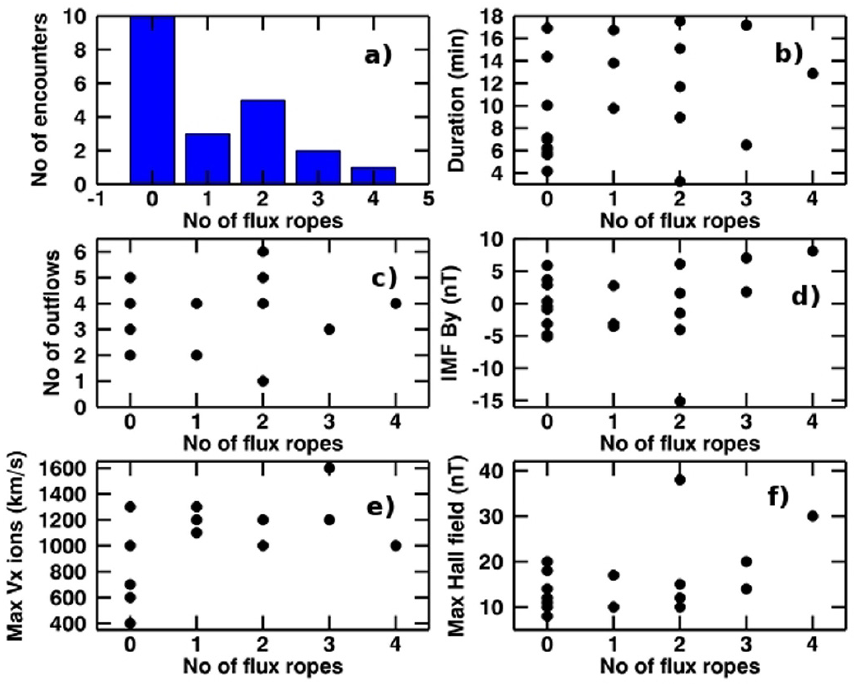
Fig. 3. The number of flux ropes observed during a SC4 X-line encounter versus (a) the total number of encounters during which this number of flux ropes was observed, (b) the total duration (in minutes) of reconnection outflow observed during the encounter, (c) the number of separate outflow episodes observed during the encounter, (d) the 3h average of the interplanetary magnetic field (IMF) Y component at the bow shock nose before the start of the encounter, (e) the maximum magnitude of the ion outflow velocity (GSM V x component) during the X-line encounter and (f) the maximum magnitude of the Hall magnetic field (GSM B y